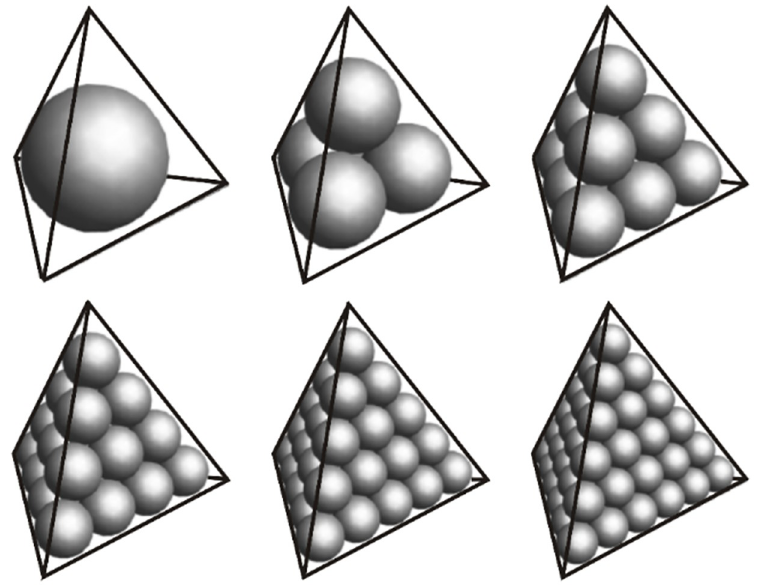
Fig 7. Schematic diagram of cubic close-packed structures of the element integration points.